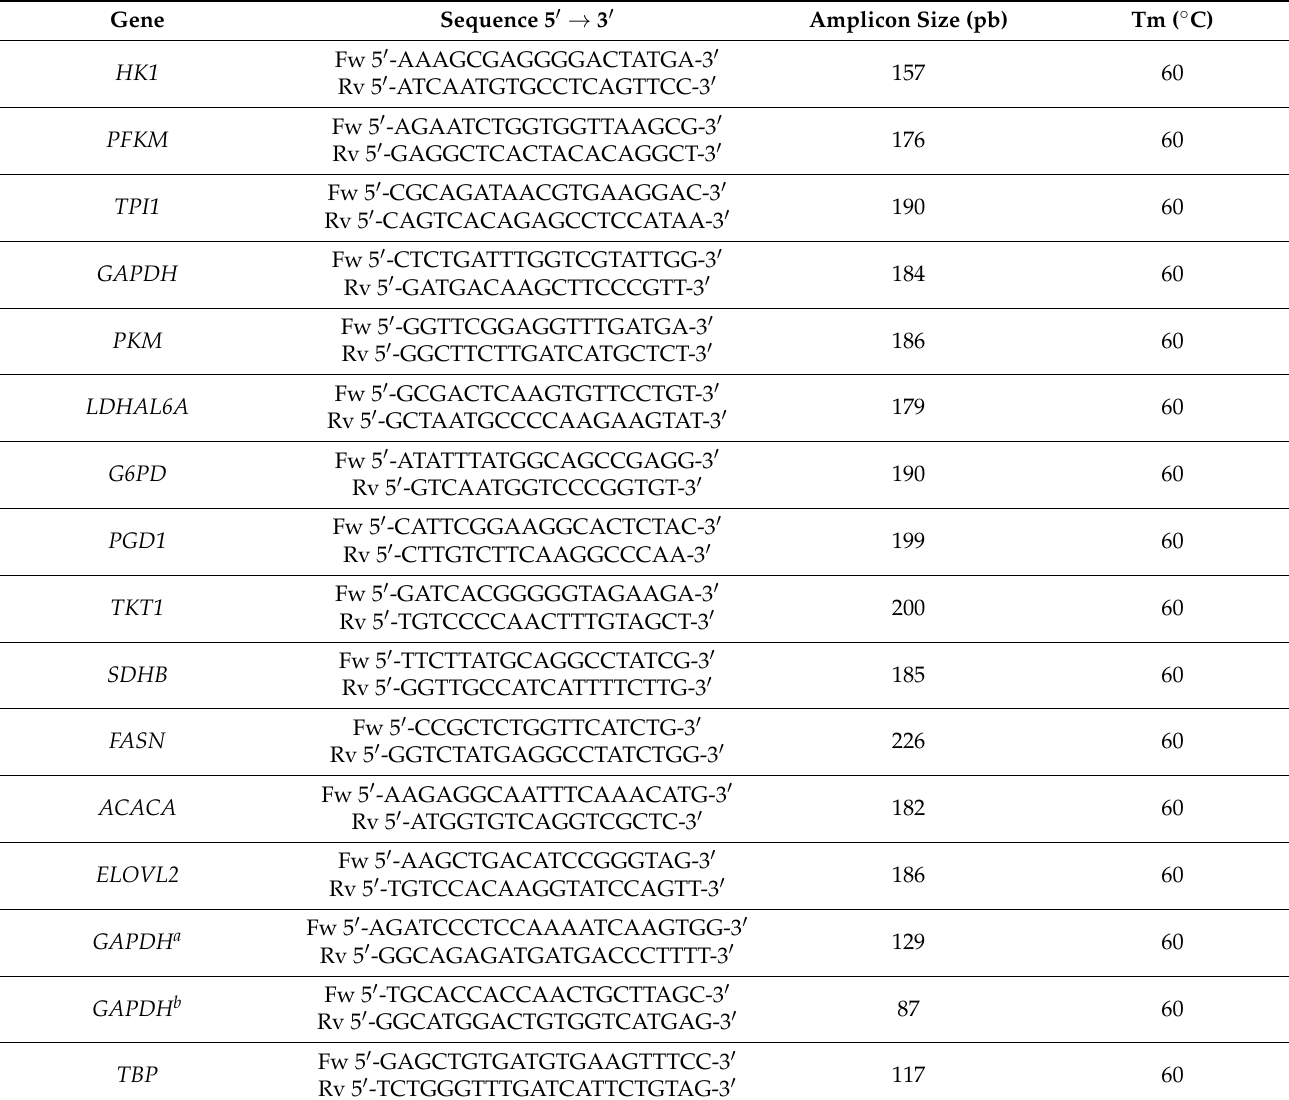
Table 2. Sequence of primers used in this